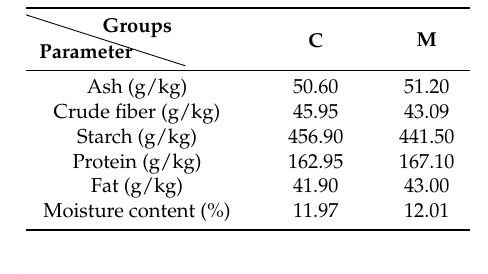
Table 1. Proximate chemical composition of pig diets.